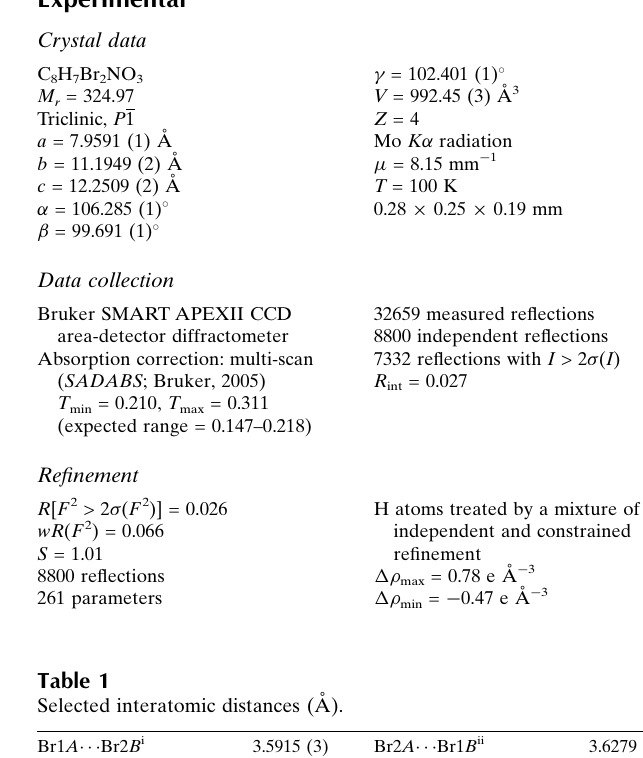
Selected interatomic distances (A˚ ).